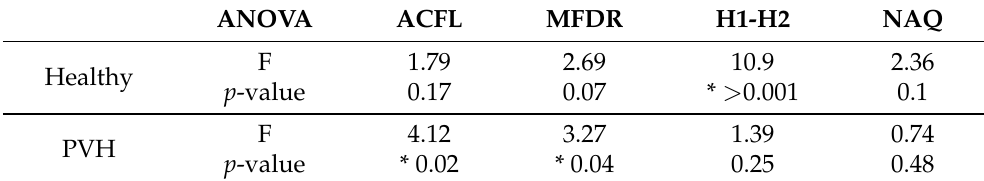
Table 3. One-way ANOVA table with mean values of glottal flow features for both Healthy and PVH subjects when comparing the standard IBIF, the modified Kalman filter, and the ground-truth GVV (* Statistically differences: p <